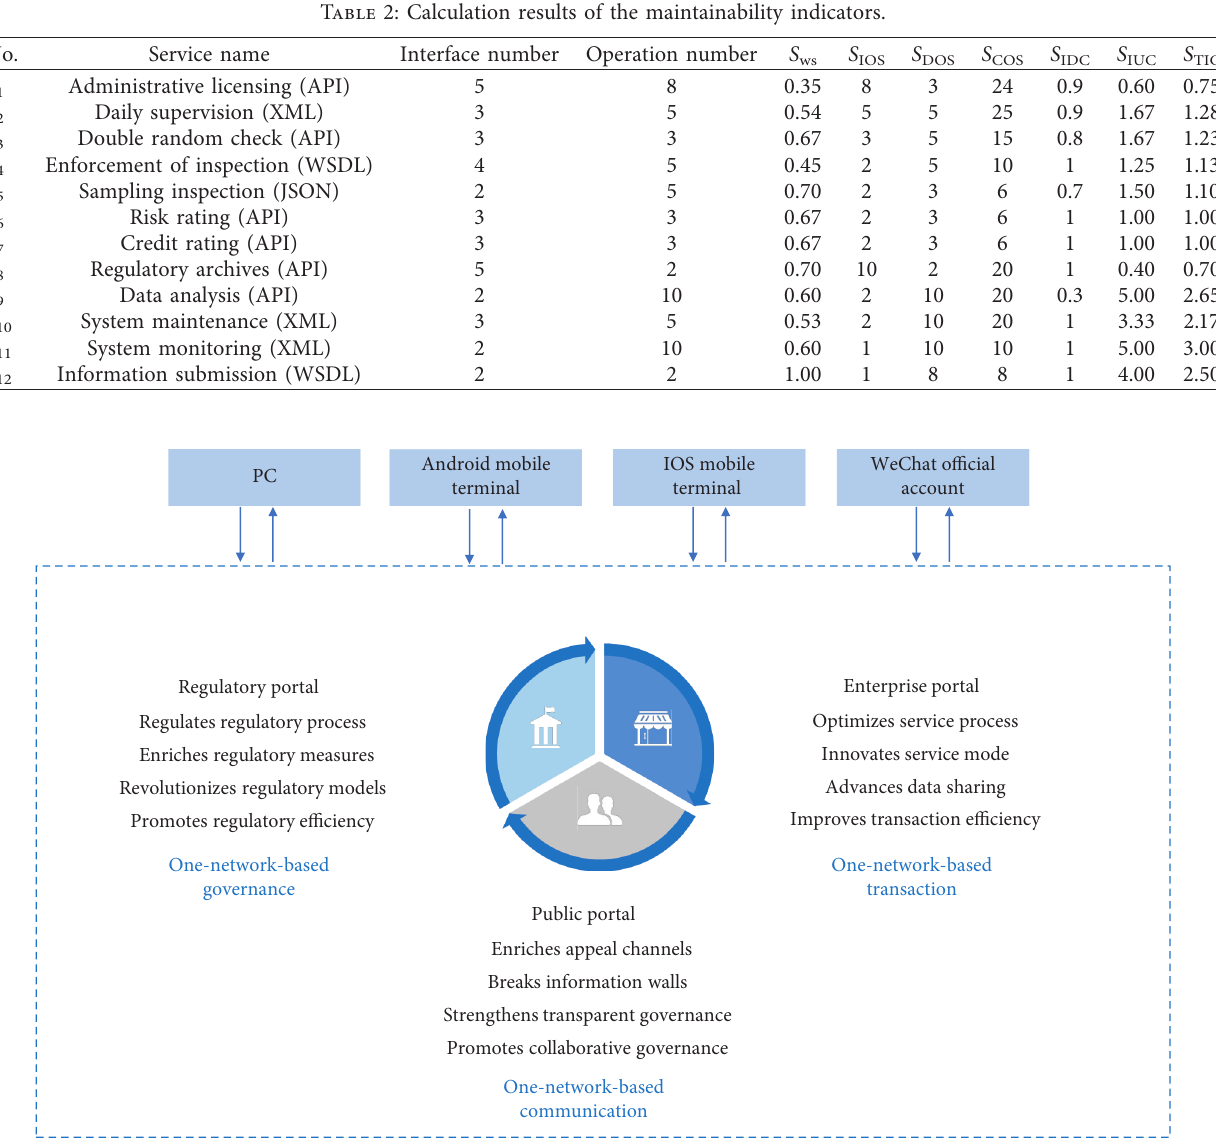
Figure 8: Value effect of “three portals, four terminals.”